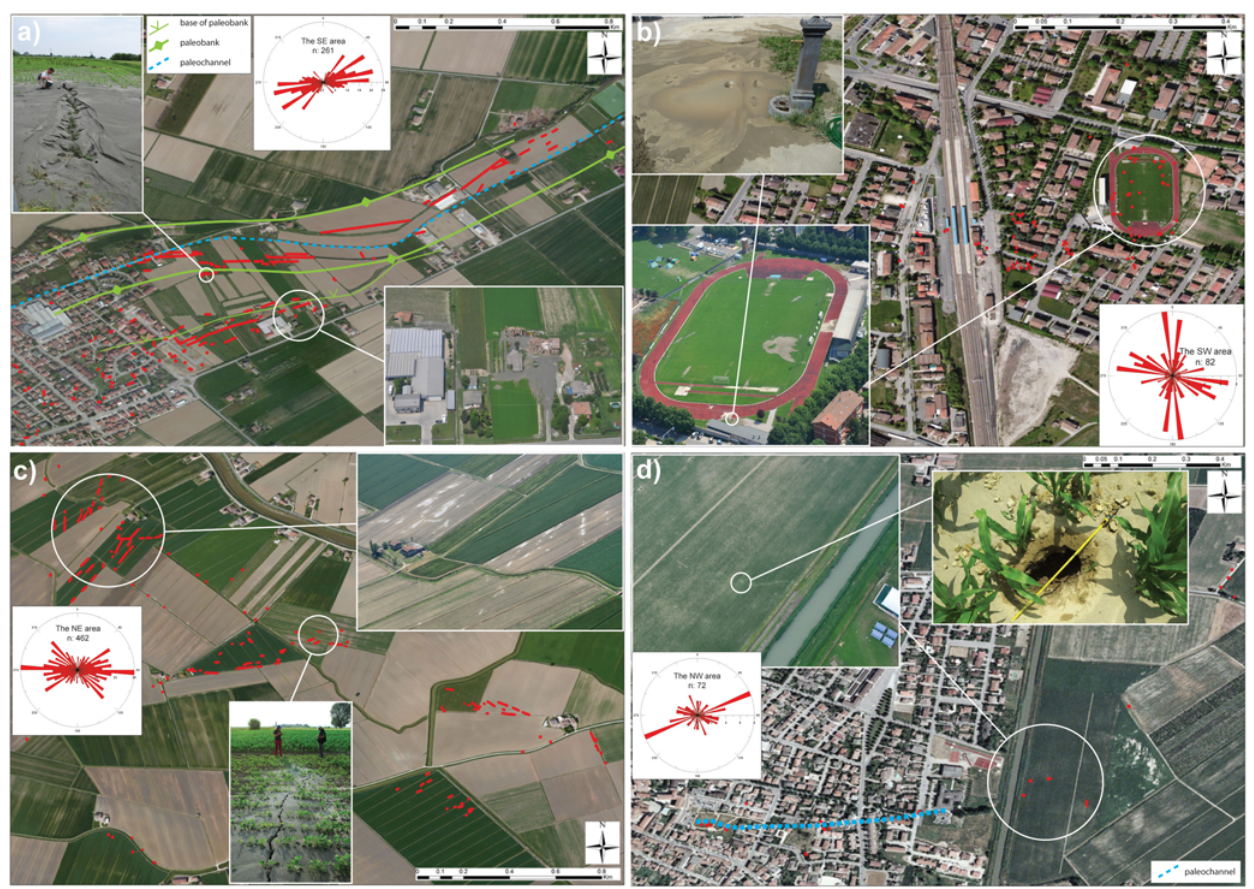
Fig. 5. Examples of coseismic geological effects of the four study areas at different scales of observation (satellite view from Bing Maps; aerial and field view from Emergeo survey). Red dots indicate the coseismic feature locations. The inset shows the rose diagram displaying the trend distribution of the linear coseismic geological effects. (a) SE area. Fractures and fractures/liquefactions following the paleochannel morphologies close to San Carlo village. The aerial view shows a large volume of sand outflow. The detail shows the fracture/liquefaction affecting the top of the paleobank; (b) SW area. Distribution of liquefactions and fractures/liquefactions at San Felice sul Panaro village. The aerial view shows the trends of the fractures/liquefactions affecting the soccer field. The detail shows the reactivation of the liquefaction occurred on 29 May through a water well; (c) NE area. Fractures/liquefactions showing a meander-like, complex alignment west of Bondeno village. The aerial view displays the variability of the fractures/liquefactions trends evidenced by the ploughed field. A detail of the frac- ture/liquefaction is shown; (d) NW area. Distribution of liquefactions and fractures/liquefactions at Quistello village aligned along a buried channel. The aerial view shows a ten-of-metres long fractures/liquefactions. A detail of the fracture/liquefaction presents a sink-hole with soil chips ejected over the sand volcano